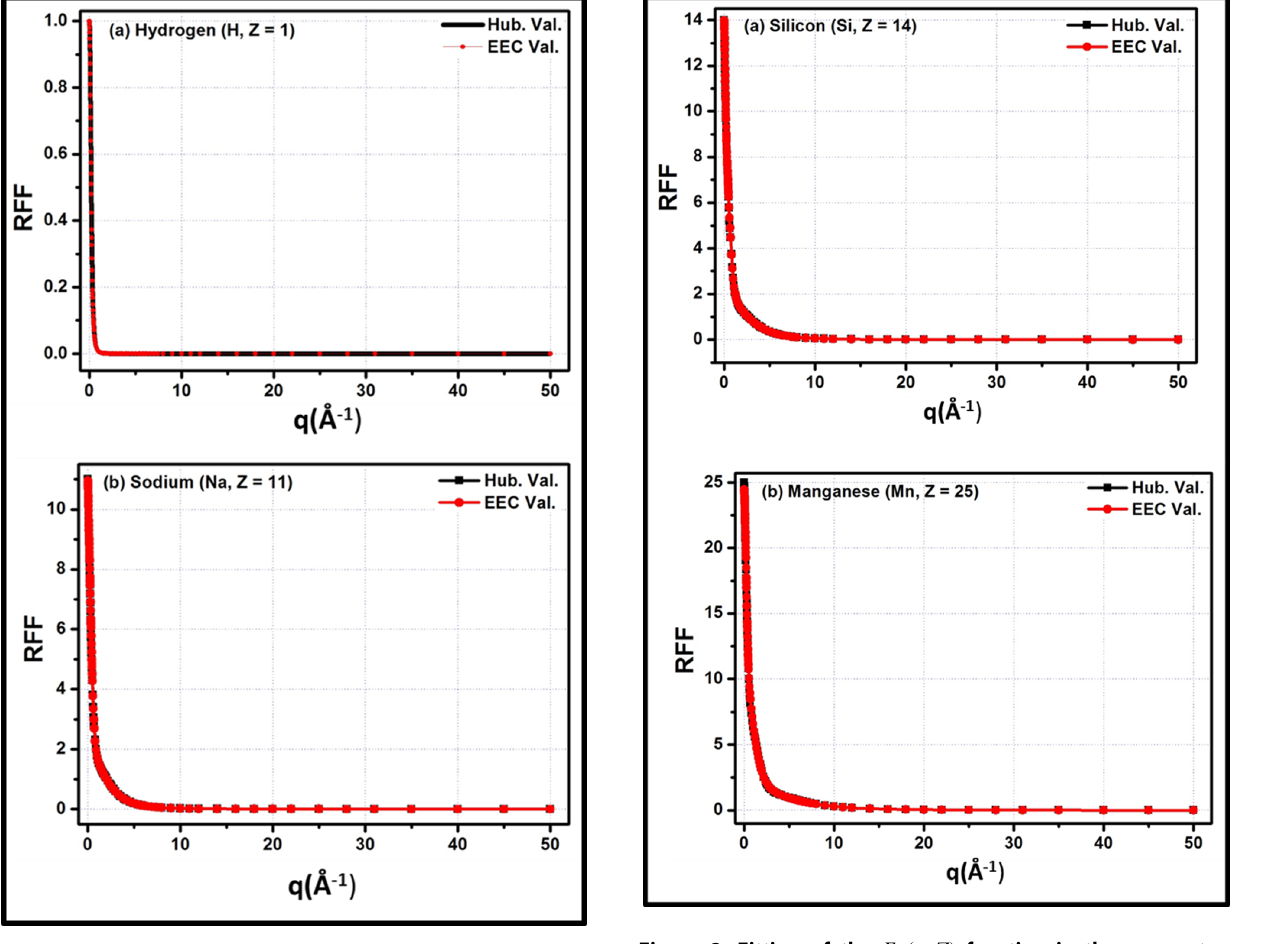
Figure 1. Fitting of the F H ( q i , Z ) function in the momentum transfer range, q=0–50 A˚ 2 1 for (a) Hydrogen (H, Z=1) (b) Sodium (Na, Z=11). Here, Hub. Val. Indicates F H ( q i , Z ) and EEC val. indicates Empirical Equation Calculated values.